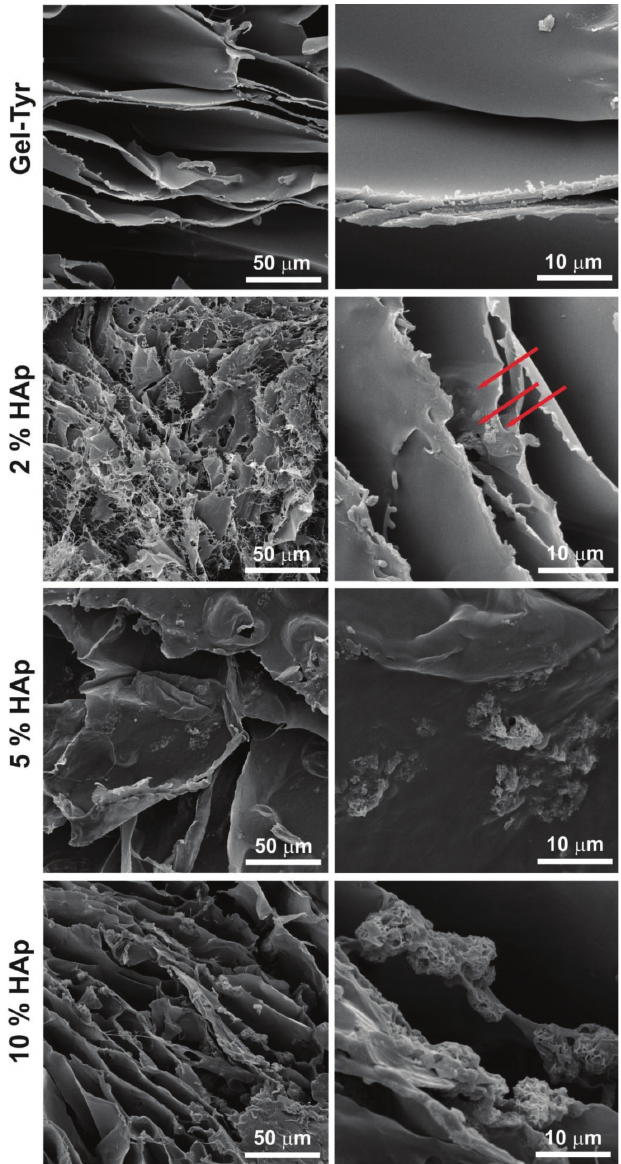
Fig. 4 – SEM micrographs of gelatine (Gel-Tyr) and Gel-Tyr/ HAp composites with different HAp content (2 % HAp, 5 % HAp, and 10 %